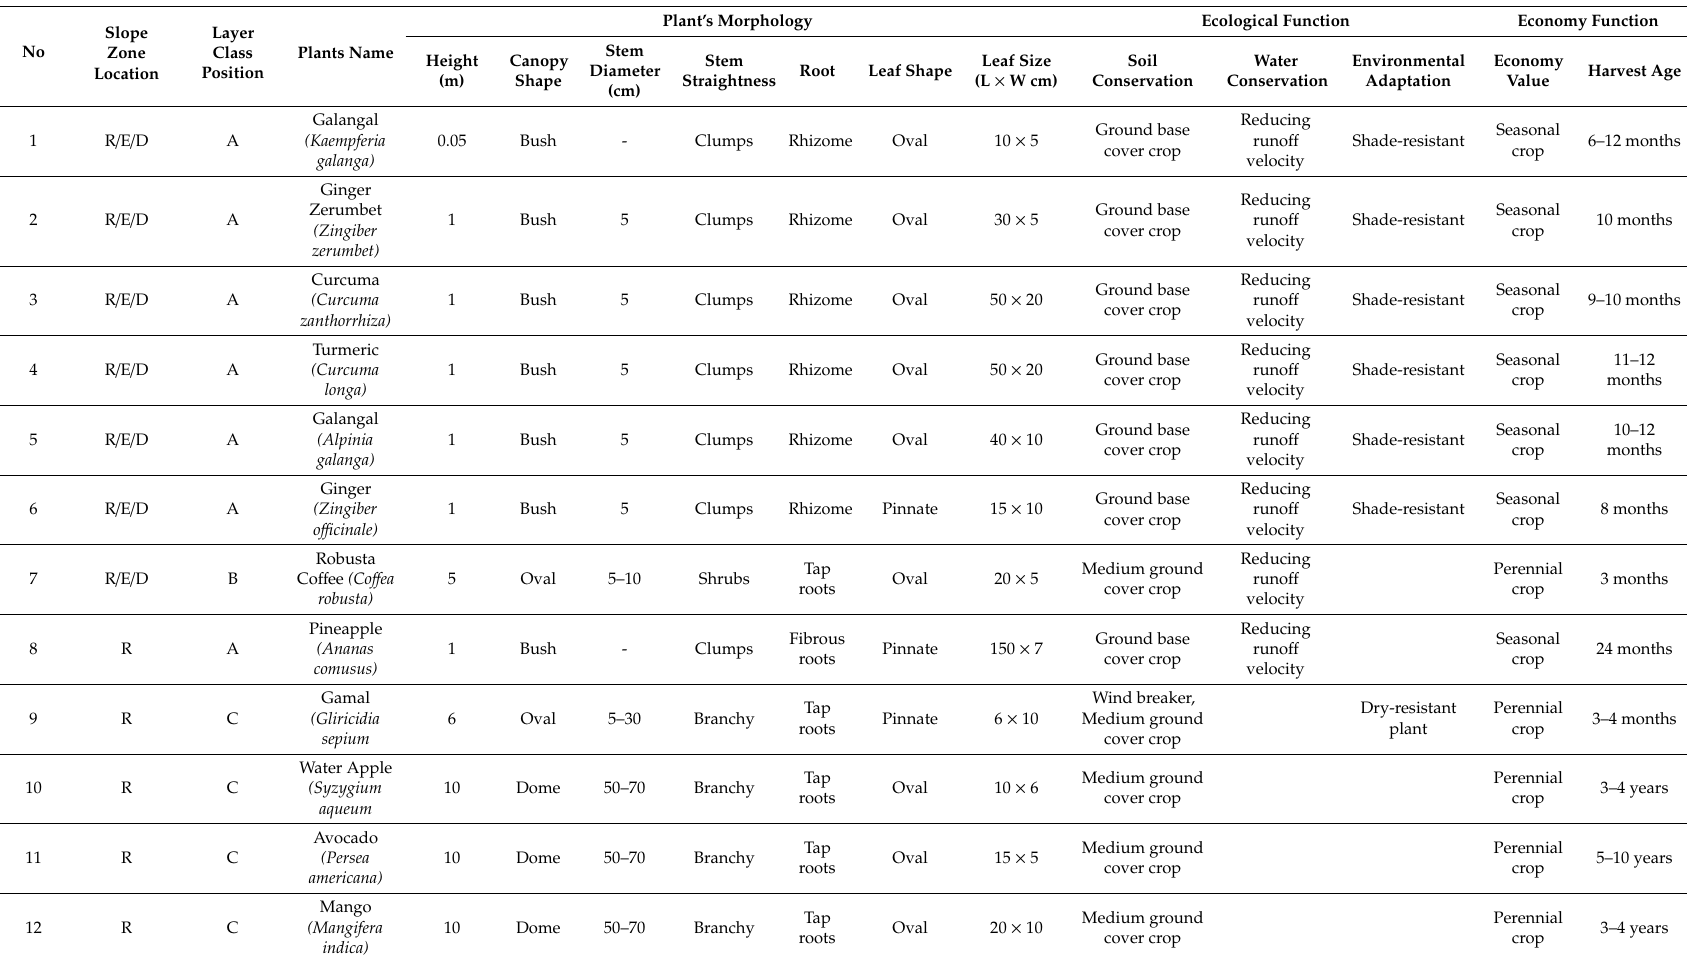
Table 3. Recommendation of the Selection and Arrangement of Local Vegetation Based on the Slope Unit